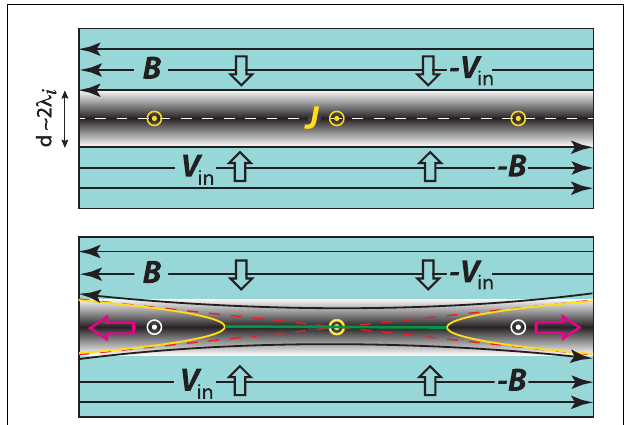
FIGURE 4 | Top: Initial state of a two-dimensional thin current sheet J separating two antiparallel fields in a completely magnetized plasma. The width is of the current sheet is d ∼ 2 λ i . Open arrows show the plasma inflow from both sides before reconnection sets on. Bottom: During reconnection the current sheet breaks off, and an X point is formed (indicated by the two dashed red separatrices). Connected field lines are shown in yellow forming plasmonds to both sides and producing two plasma jets (red arrows). The thin green line across the X point shows the extension of the electron diffusion region . In the normal direction it is just two λ e . along the current sheet its extension is much longer, possibly of the order of a few ion inertial lengths. In this region electrons are heated and jetted away from the X point to become two electron jets. These jets disappear at the end of the electron diffusion region where ions take part in the